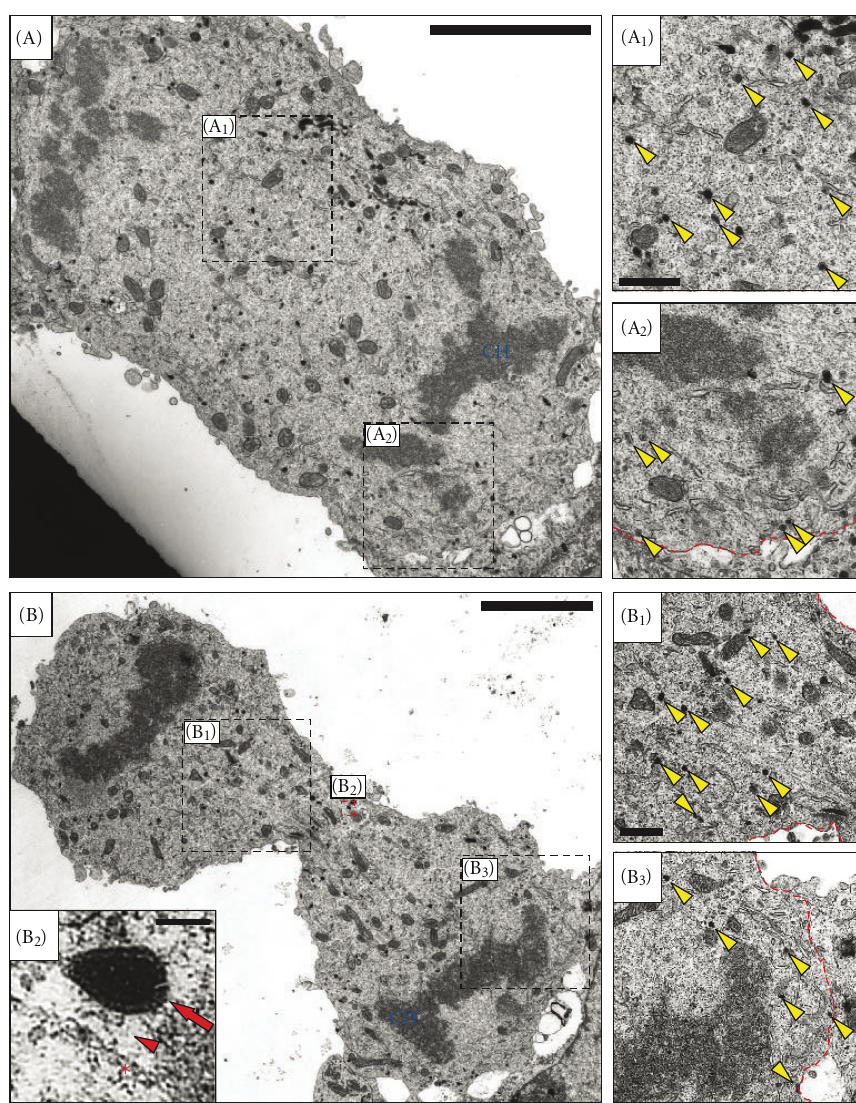
Figure 6: Ultrastructural analysis of the distribution of SGs during late stages of mitosis. Synchronized PC12 cell populations were processed for TEM. Shown are cells at anaphase (A) and telophase (B) and the respective magnified boxed areas on the right compare the density of SGs in the midzone ((A 1 )/(B 1 )) and the polar periphery ((A 2 )/(B 3 )). Please note that SGs are preferentially distributed in the cell midzone. Panel B 2 is a magnification of the boxed region in panel B. Please note the close association of an SG (red arrow) with a microtubule fiber (red asterisk) and an apparent linker structure (red arrowhead) reminiscent of a motor protein. CH, chromosome. Scale bars, panels (A) and (B), 5 μ m; panels (A 1 ), (A 2 ), (B 1 ), and (B 3 ), 500 nm; panel (B 2 ),